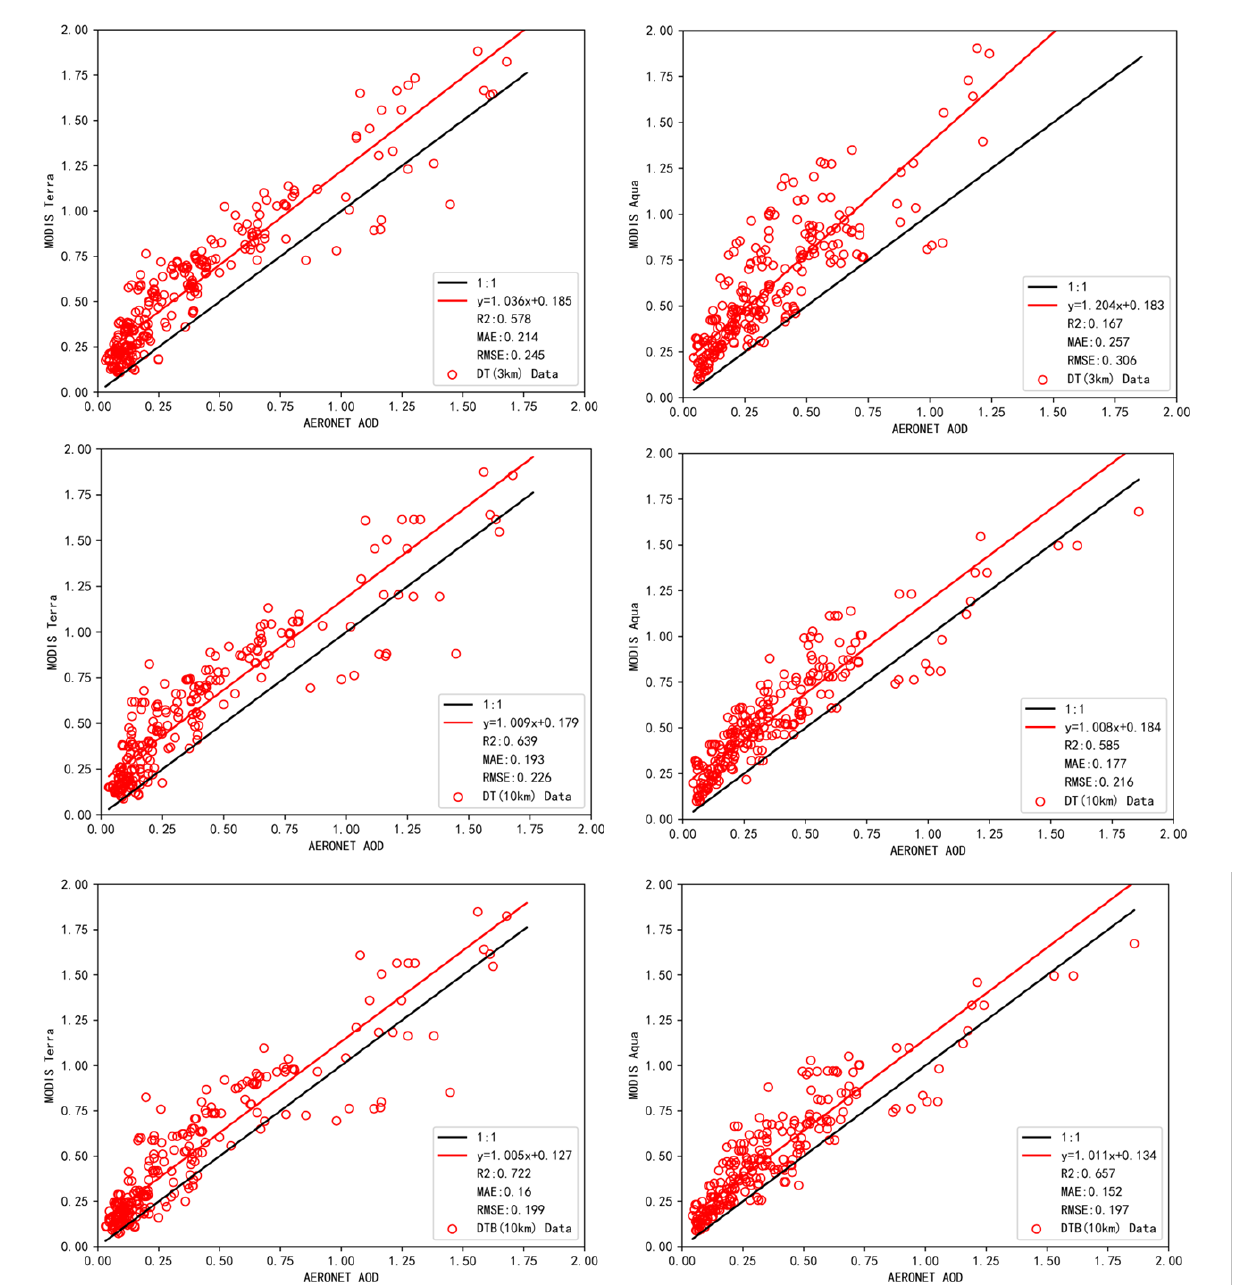
Figure 3 . Comparison between 3km DT, 10km DT, and 10km DTB AOD products with AERONET AOD